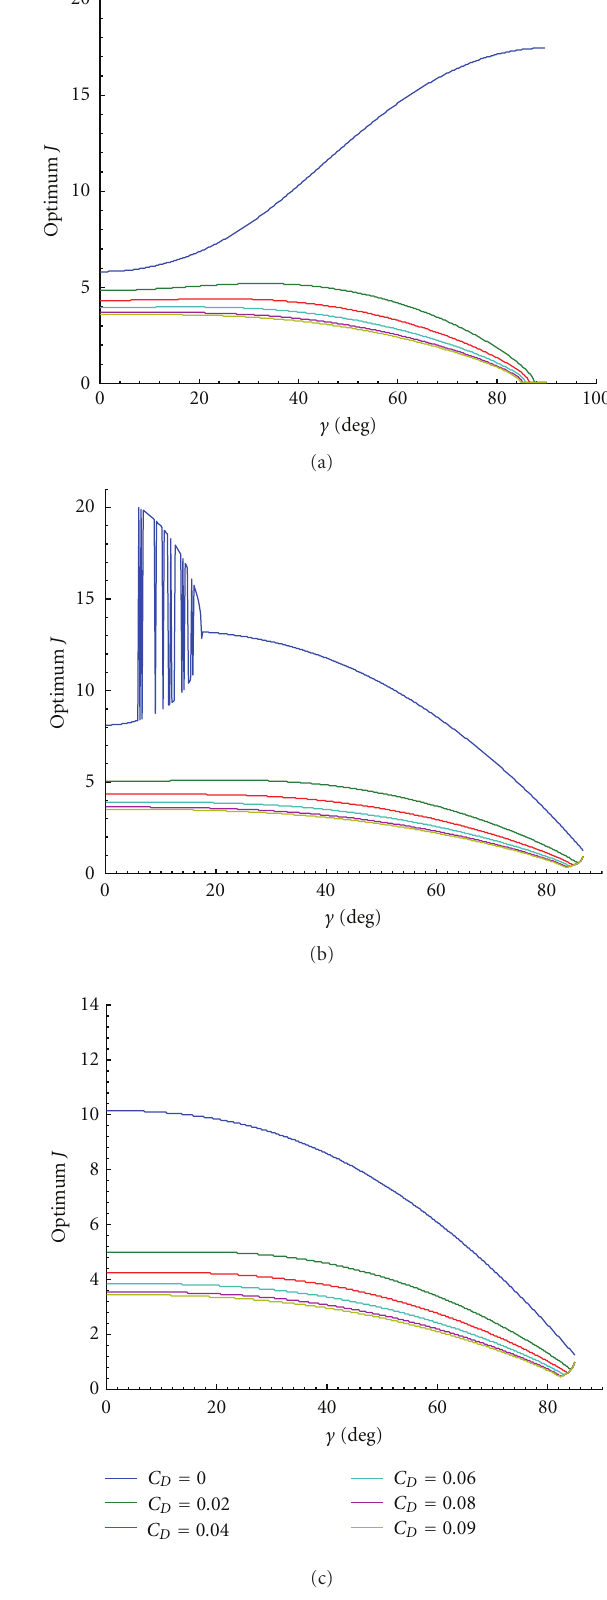
Figure 20: (a) Max C P versus γ for θ = 0 ◦ , (b) Max C P versus γ for γ for θ = 3 ◦ . θ = 2 ◦ , and (c) Max C P versus